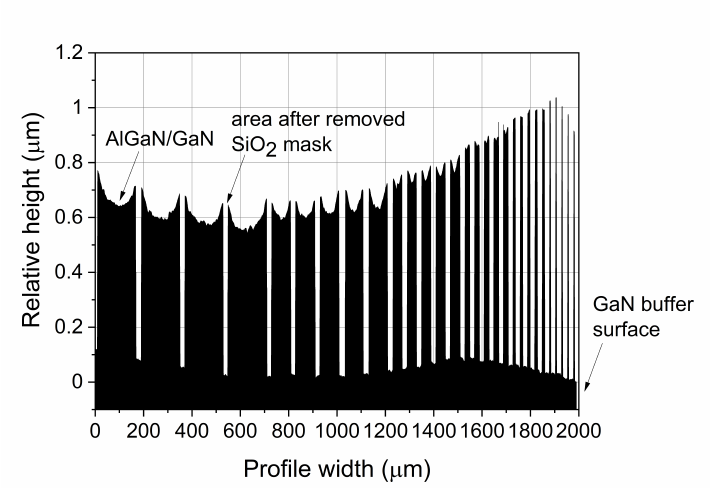
Figure 3. Part of the AlGaN/GaN heterostructure profile with 500 nm thick GaN